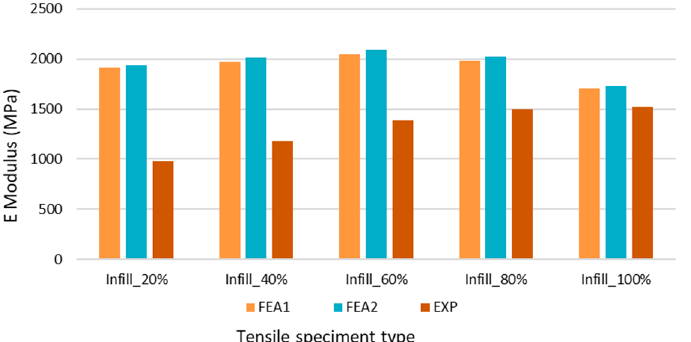
Figure 15. E-moduli value for different infill rates recalculated based on numerically estimated cross-sectional areas.